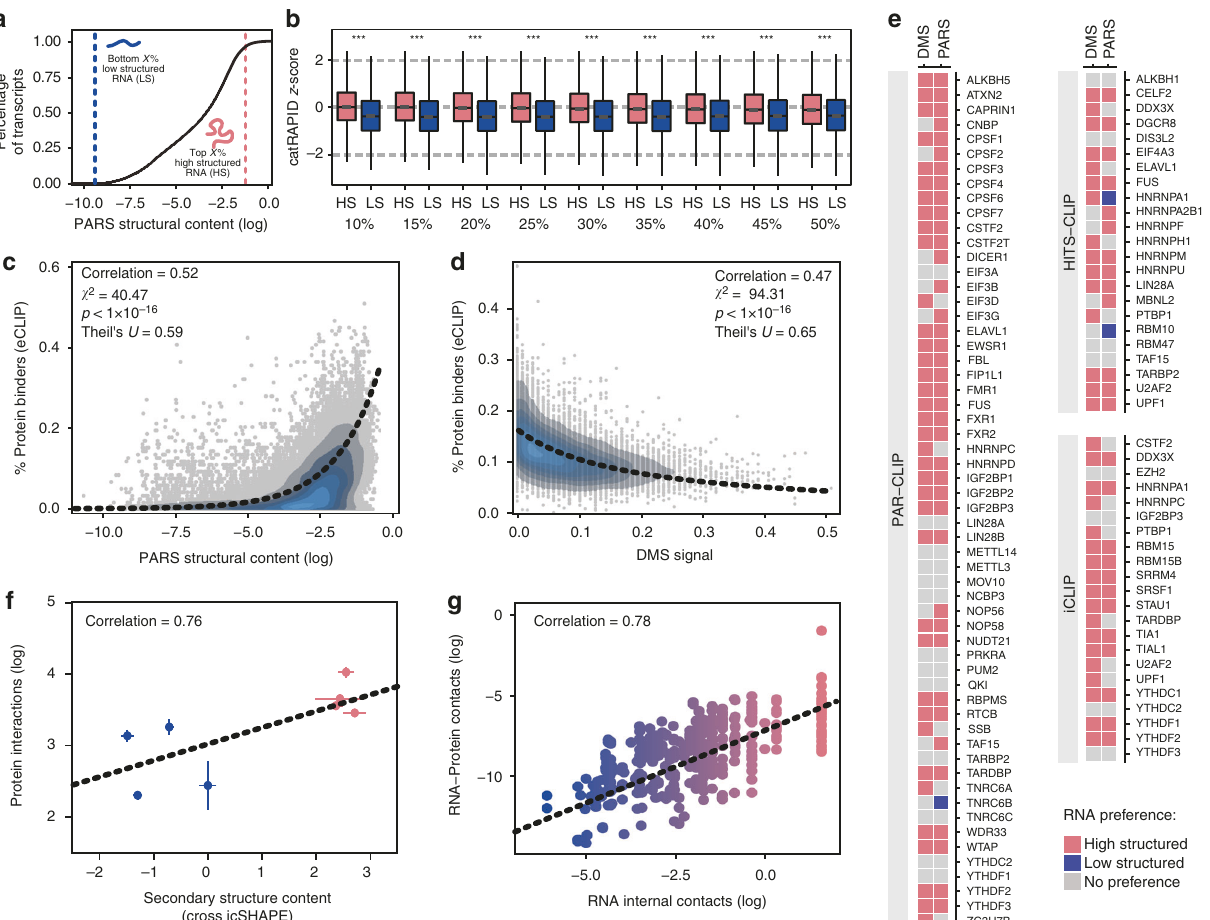
Fig. 1 The amount of protein structure correlates with the number of interactions. a Cumulative distribution function (CDF) for the secondary structure content of all human RNAs measured by parallel analysis of RNA structure (PARS) 8,69 . Vertical lines indicate a certain fraction ( X %) of RNAs with the lowest secondary content (LS; blue) and the same fraction with the highest secondary content (HS; pink). b catRAPID predictions of protein interactions with human RNAs ranked by structural content measured by PARS (118 RNA-binding proteins (RBPs) for which enhanced crosslinking and immunoprecipitation (eCLIP) information is also available) 31 . The fractions 10%, 15%, … , 50% refer to the comparison between equal-size HS and LS sets. The results indicate that catRAPID is able to distinguish HS and LS groups signi fi cantly and consistently through the different fractions ( p value <10 – 16 ; Kolmogorov – Smirnov (KS) test). The boxes show the interquartile range (IQR), the central line represents the median, the whiskers add 1.5 times the IQR to the 75 percentile (box upper limit) and subtract 1.5 times the IQR from the 25 percentile (box lower limit). s.d. is shown. c Relationship between number of protein interactions (eCLIP) and structural content measured by PARS 30 . The fi tting line corresponds to the formula y = exp( α + β x ), where α = − 0.75; β = 0.67; p value estimated with KS test. d Relationship between number of protein interactions and structural content measured by dimethyl sulfate modi fi cation (DMS) 9 . The fi tting line corresponds to the formula y = 1/( α + β x ), where α = 2.60; β = 87.36; p value estimated with KS test. e Structural preferences of RBPs measured with three different CLIP techniques (photoactivatable ribonucleoside-enhanced CLIP (PAR-CLIP), high-throughput sequencing-CLIP (HITS-CLIP) and individual nucleotide resolution CLIP (iCLIP)). The colour indicates the RNA-binding preference of each protein: pink, high structured; blue, low structured; grey, no preference. f Correlation between structural content (CROSS predictions of icSHAPE experiments) and protein interactions of eight transcripts revealed by protein microarrays (Pearson ’ s correlation). s.d. is shown. g Analysis of Protein Data Bank (PDB) structures containing protein – RNA complexes reveals a trend between protein (inter) and RNA (intra) contacts (196 different pairs; Pearson ’ s correlation)